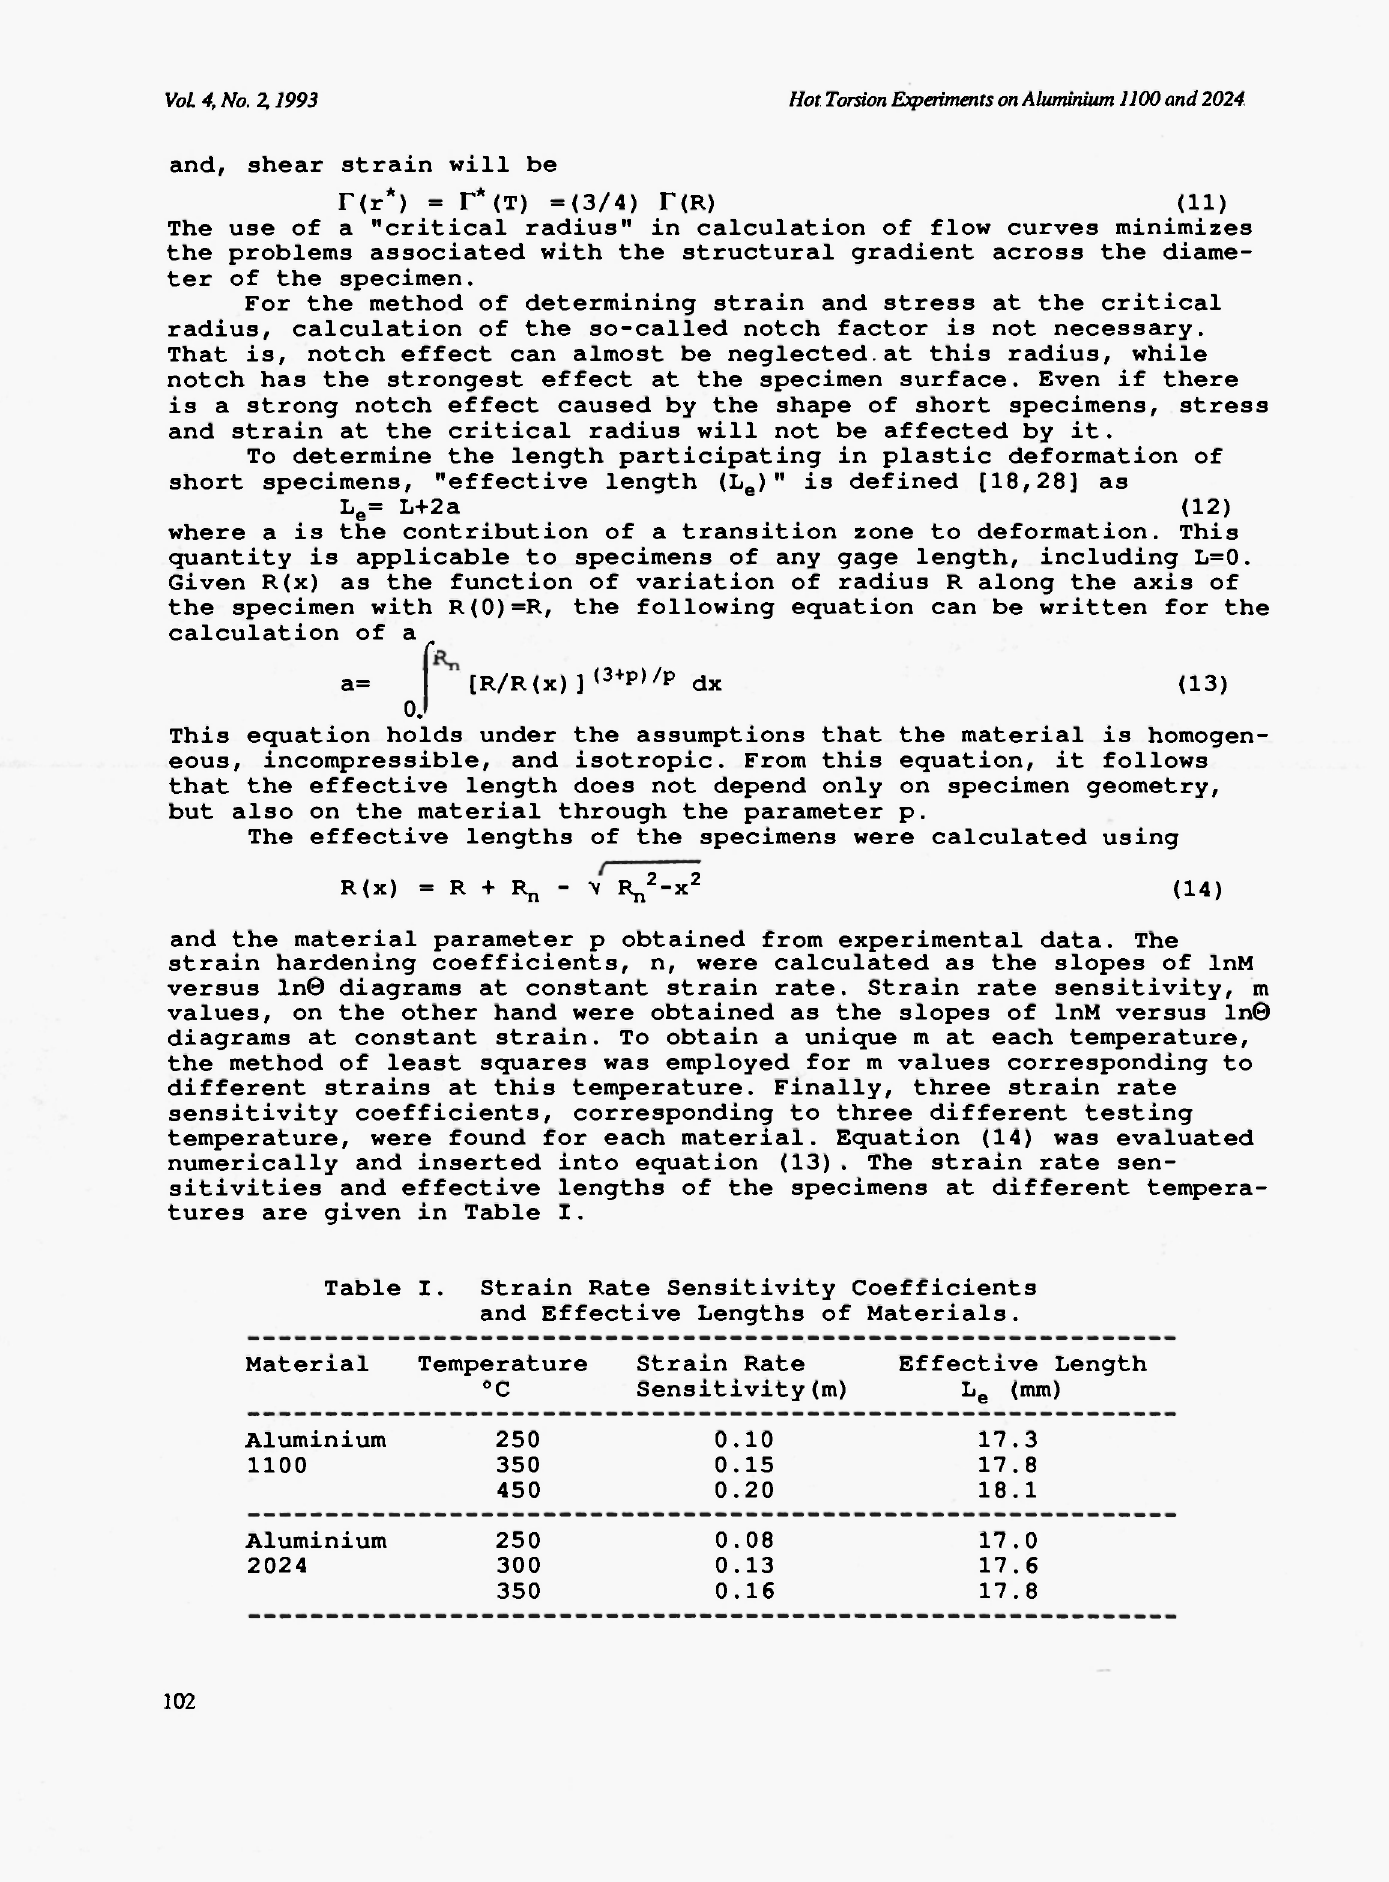
Strain Rate Sensitivity Coefficients and Effective Lengths of